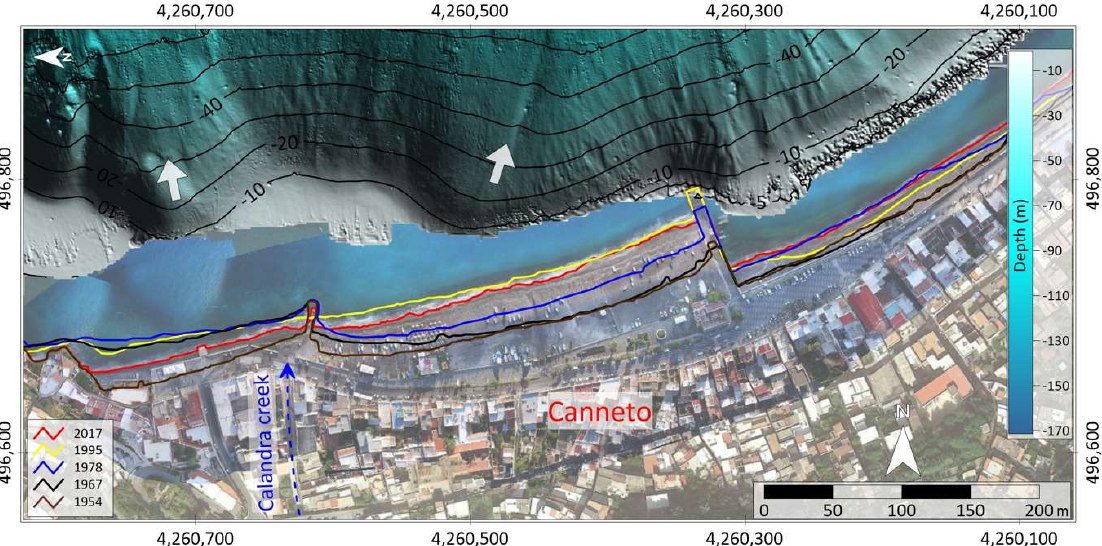
Figure 10. Map of the northern Canneto sector and selected shorelines. White arrows show the active canyon heads located in the nearshore. Location in Figure 1.